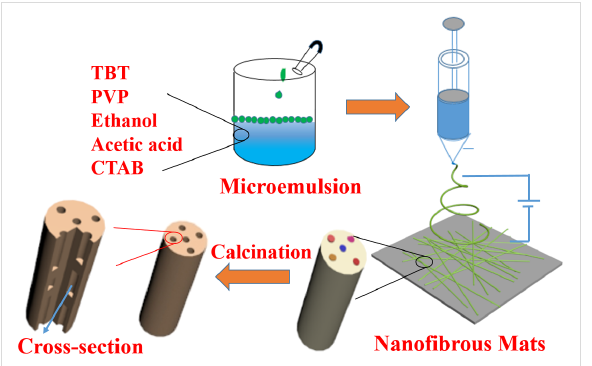
Figure 1: Fabrication procedure of porous TiO 2 nanofibers via